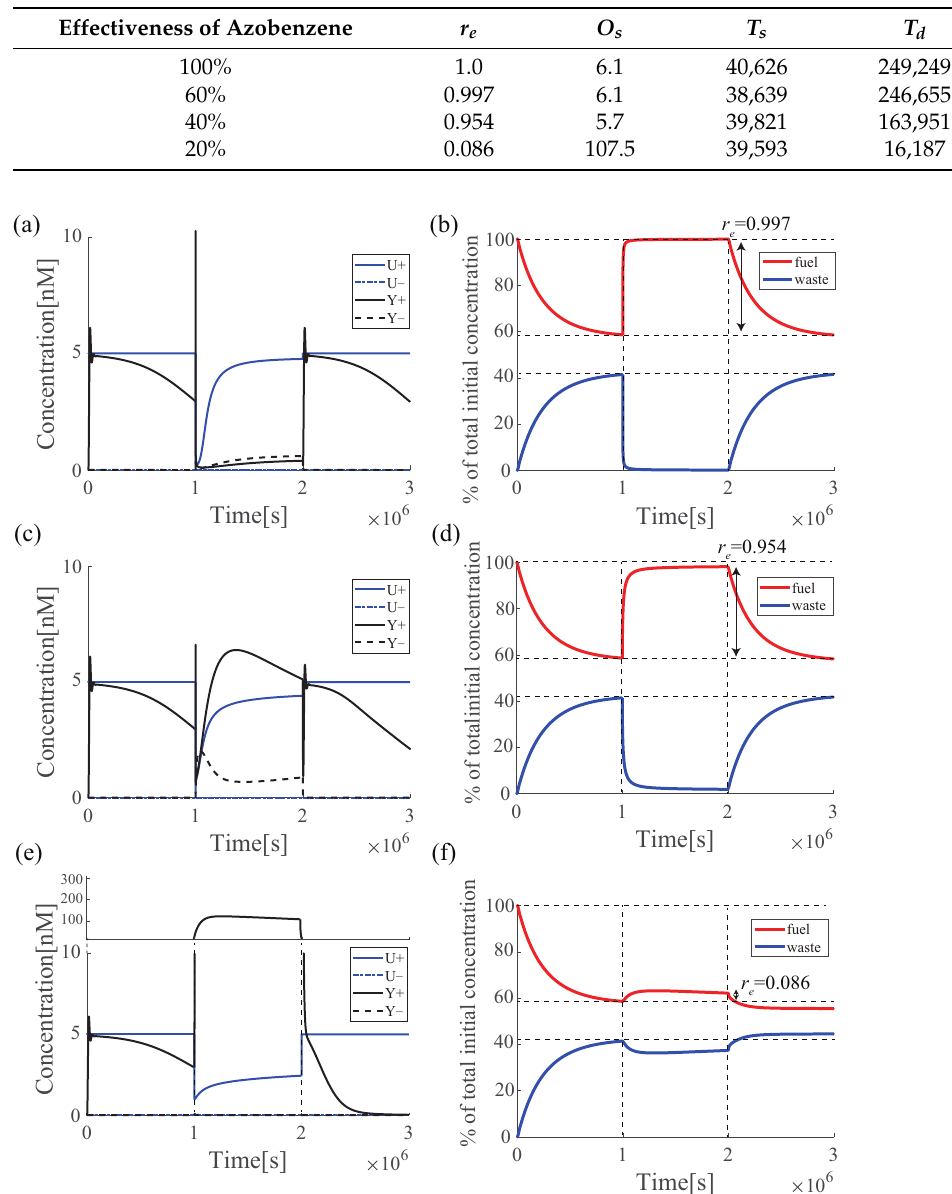
Figure 7. Performance and fuel DNA renewable of azo-PI controller at each effectiveness value of azobenzene. ( a ) Simulation result of performance renewable in input U (blue line) and output Y (black line); ( b ) total concentration of fuel(red) and waste (blue) strands when the effectiveness of azobenzene is 60%; ( c ) simulation result of azo-PI controller in input U (blue line) and output Y (black line); ( d ) total concentration of fuel(red) and waste (blue) strands when the effectiveness of azobenzene is 40%; ( e ) simulation result of azo-PI controller in input U (blue line) and output Y (black line); and ( f ) total concentration of fuel (red) and waste (blue) strands when the effectiveness of azobenzene is 20%. The reaction rates are listed in Table